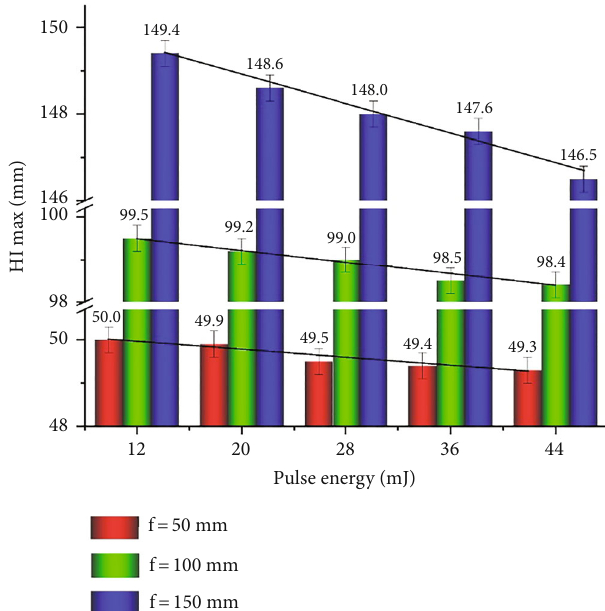
Figure 7: Graph showing the lens-to-sample distance when the maximum spectral intensity varies with pulse energy (HImax represents the lens-to-sample distance with maximum spectral intensity. The error bar is 0.3mm, coming from the procedure of H